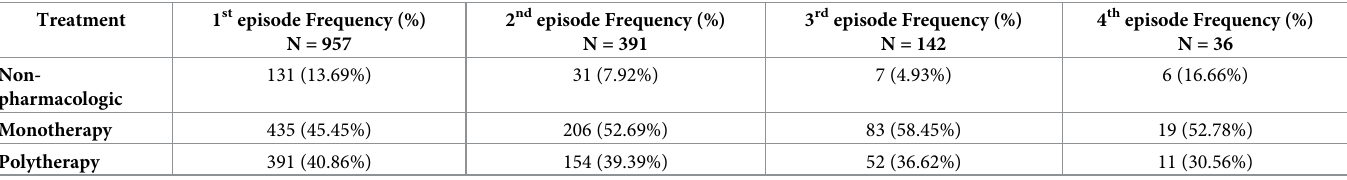
Table 3. Description (frequency and percentage) of treatment types (non-pharmacologic, monotherapy and polytherapy) for each depressive episode.